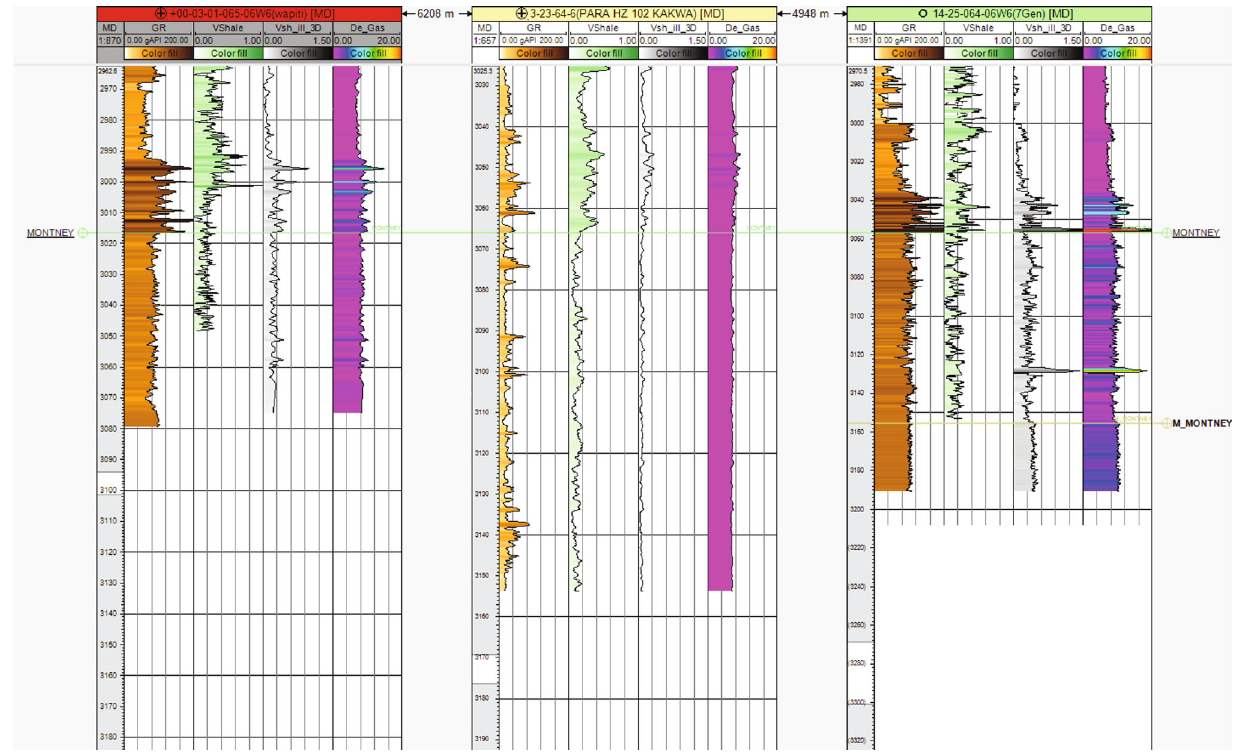
Figure 7: Well-log stratigraphy cross section showing the Montney Formation division of three wells of middle area. Belloy Formation and lower member of UWI 100030106506W600 and 100032306406W600 were not de fi ned. Upper member Montney is fl attened. Column display is equal to Figure